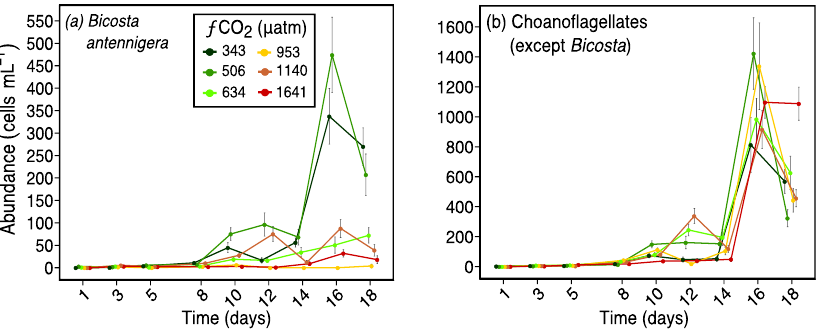
Figure 8. Abundances of (a) Bicosta antennigera , and (b) Choanoflagellates (except Bicosta ) over days 1 to 18 of the incubation of a natural protistan community in tanks maintained at different f CO 2 levels. Error bars are standard errors derived from pseudo-replicates undertaken at each time point for each treatment.